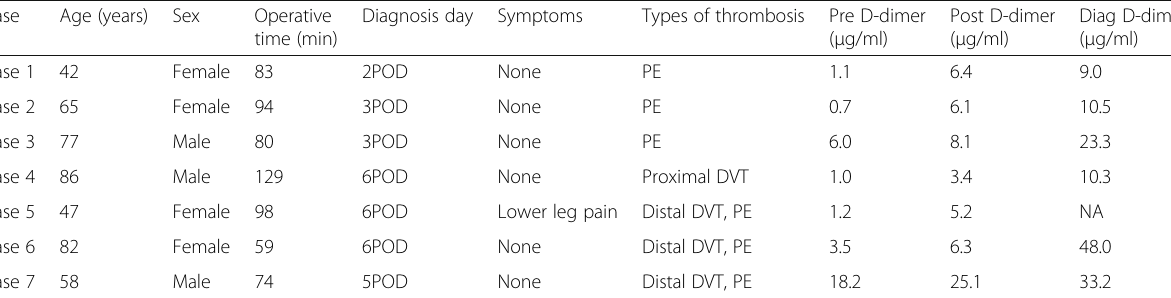
Table 1 Seven cases of deep venous thrombosis and pulmonary embolism (DVT/PE) after appendectomy